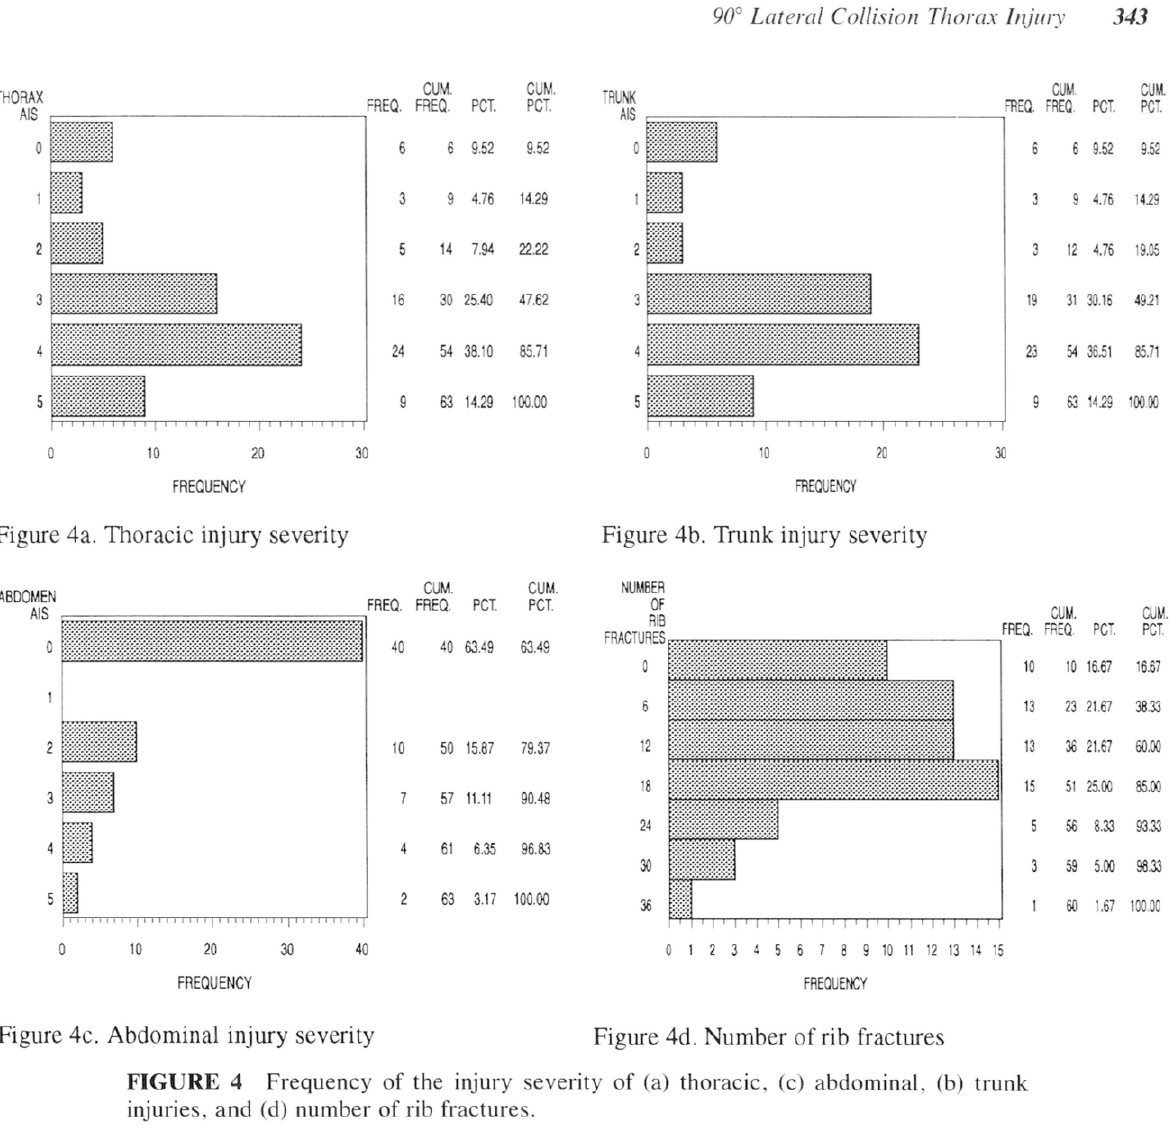
FIGURE 3 Frequency distributions of measured and evaluated mechanical responses: (a) acceleration at the fourth impacted rib; (b) acceleration at the eighth impacted rib; (c) deformation at the level of the fourth impacted rib ; (d) deformation at the level of the eighth impacted rib; (e) VC at the level of the fourth rib; (f) VC at the level of the eighth rib; and (g) acceleration at the 12th thoracic